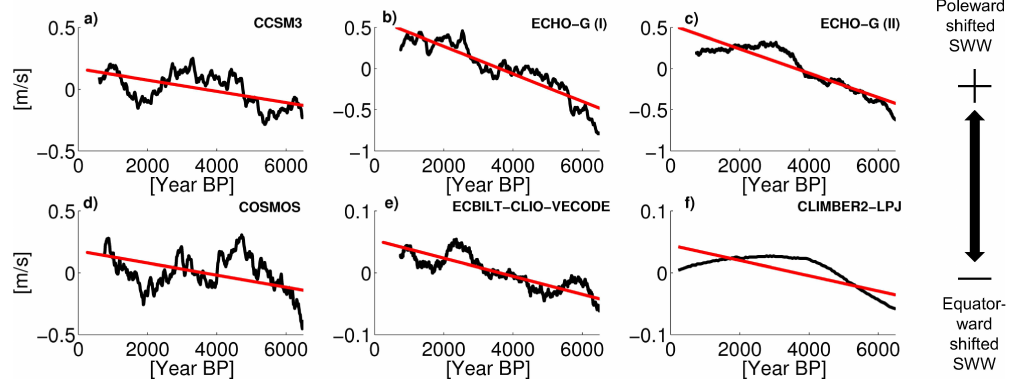
Fig. 4. Temporal evolution of annual-mean SWW position during the period 7kyr BP to 250yr BP in (a) CCSM3, (b) ECHO-G (I), (c) ECHO-G (II), (d) COSMOS, (e) ECBilt-CLIO-VECODE, and (f) CLIMBER2-LPJ, defined in terms of the difference between the latitudes 55 ◦ S and 35 ◦ S (southern and northern parts of the SWW belt respectively) of the zonally averaged low-level zonal winds (black curves). The time axis is plotted against the anomaly of the mean wind position. A 1000yr boxcar smoothing with respect to the orbital year has been applied to all the time series except for CLIMBER2-LPJ. Linear regression lines for the unsmoothed time series are shown in red. Note the different ordinate scales.